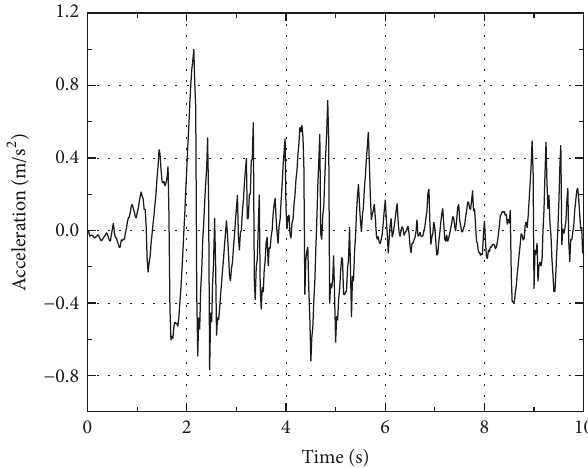
Figure 27: EI Centro acceleration time history curve.